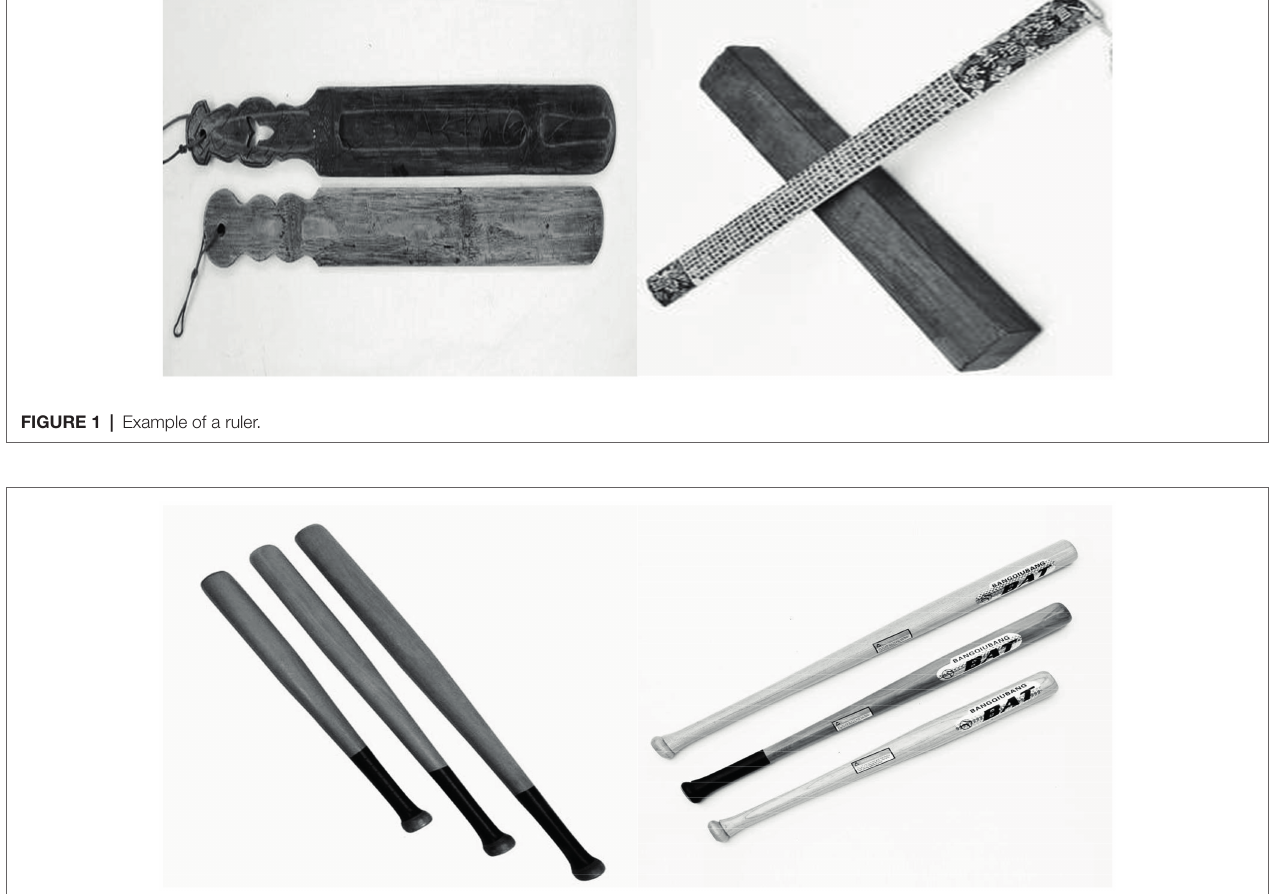
FIGURE 2 | Example of a